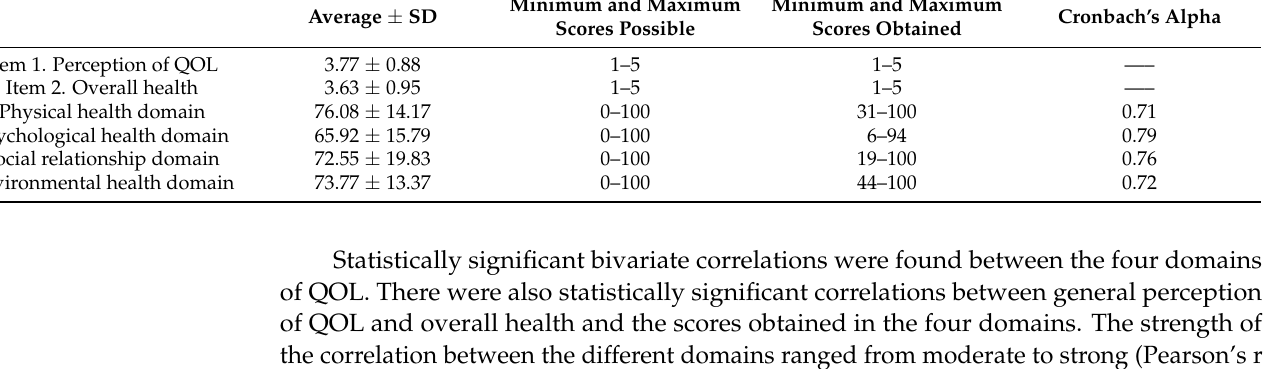
Table 3. Bivariate correlations between different domains of the WHOQOL-BREF. Item 1: Perceived QOL